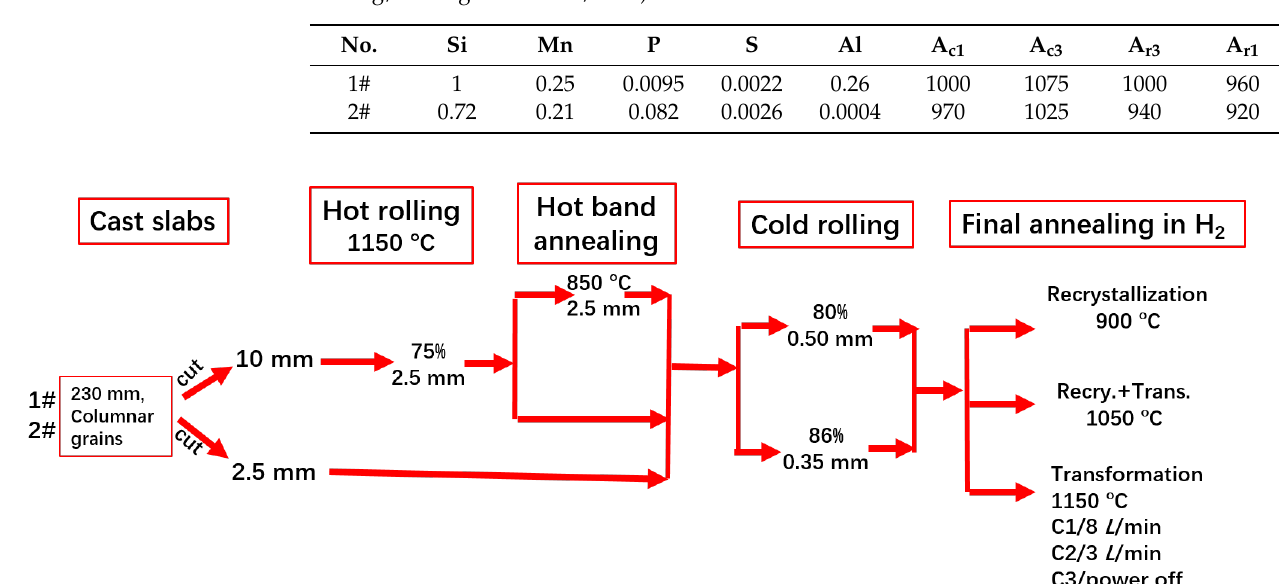
Table 1. Compositions (wt%) of samples 1# and 2# and their transformation temperatures (°C; heating/cooling rate: 10 °C/min.).